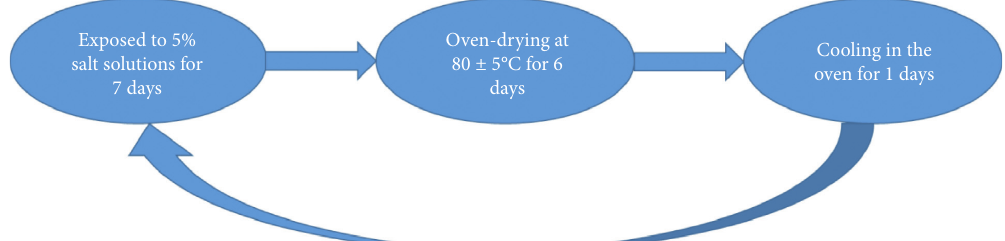
Figure 2: The process of drying-wetting cycles in 5% Na